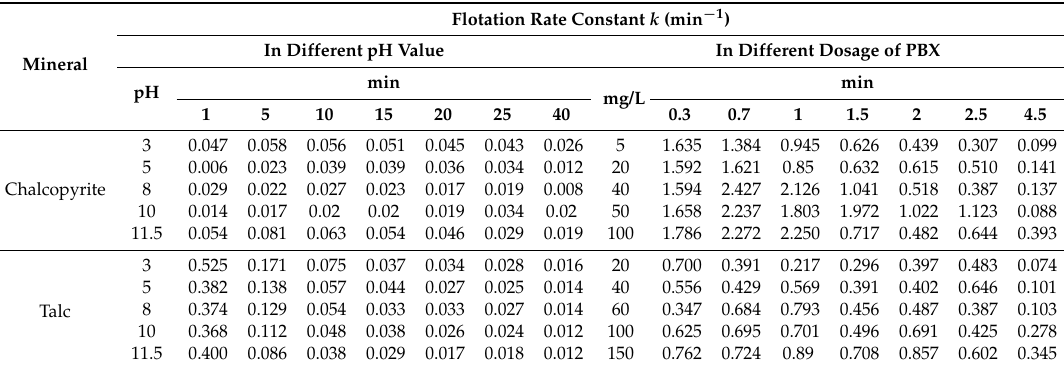
Table 1. Flotation rate calculation results of